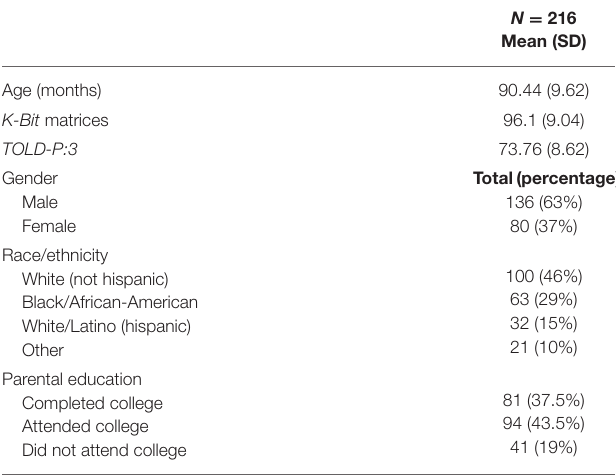
TABLE 1 | Baseline characteristics of the children who participated in the